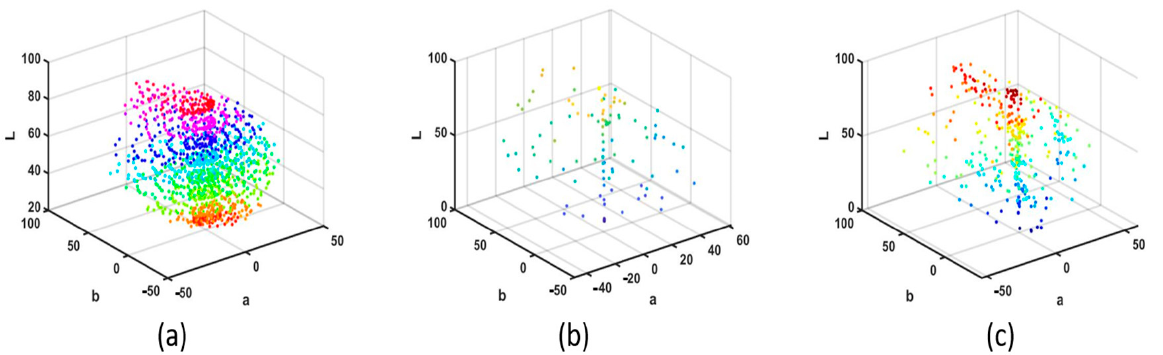
Figure 4. CIE Lab coordinate of ( a ) 1269 Munsell Matt chips, ( b ) the 140 ColorChecker SG and ( c ) the 354 Vrhel spectral dataset.